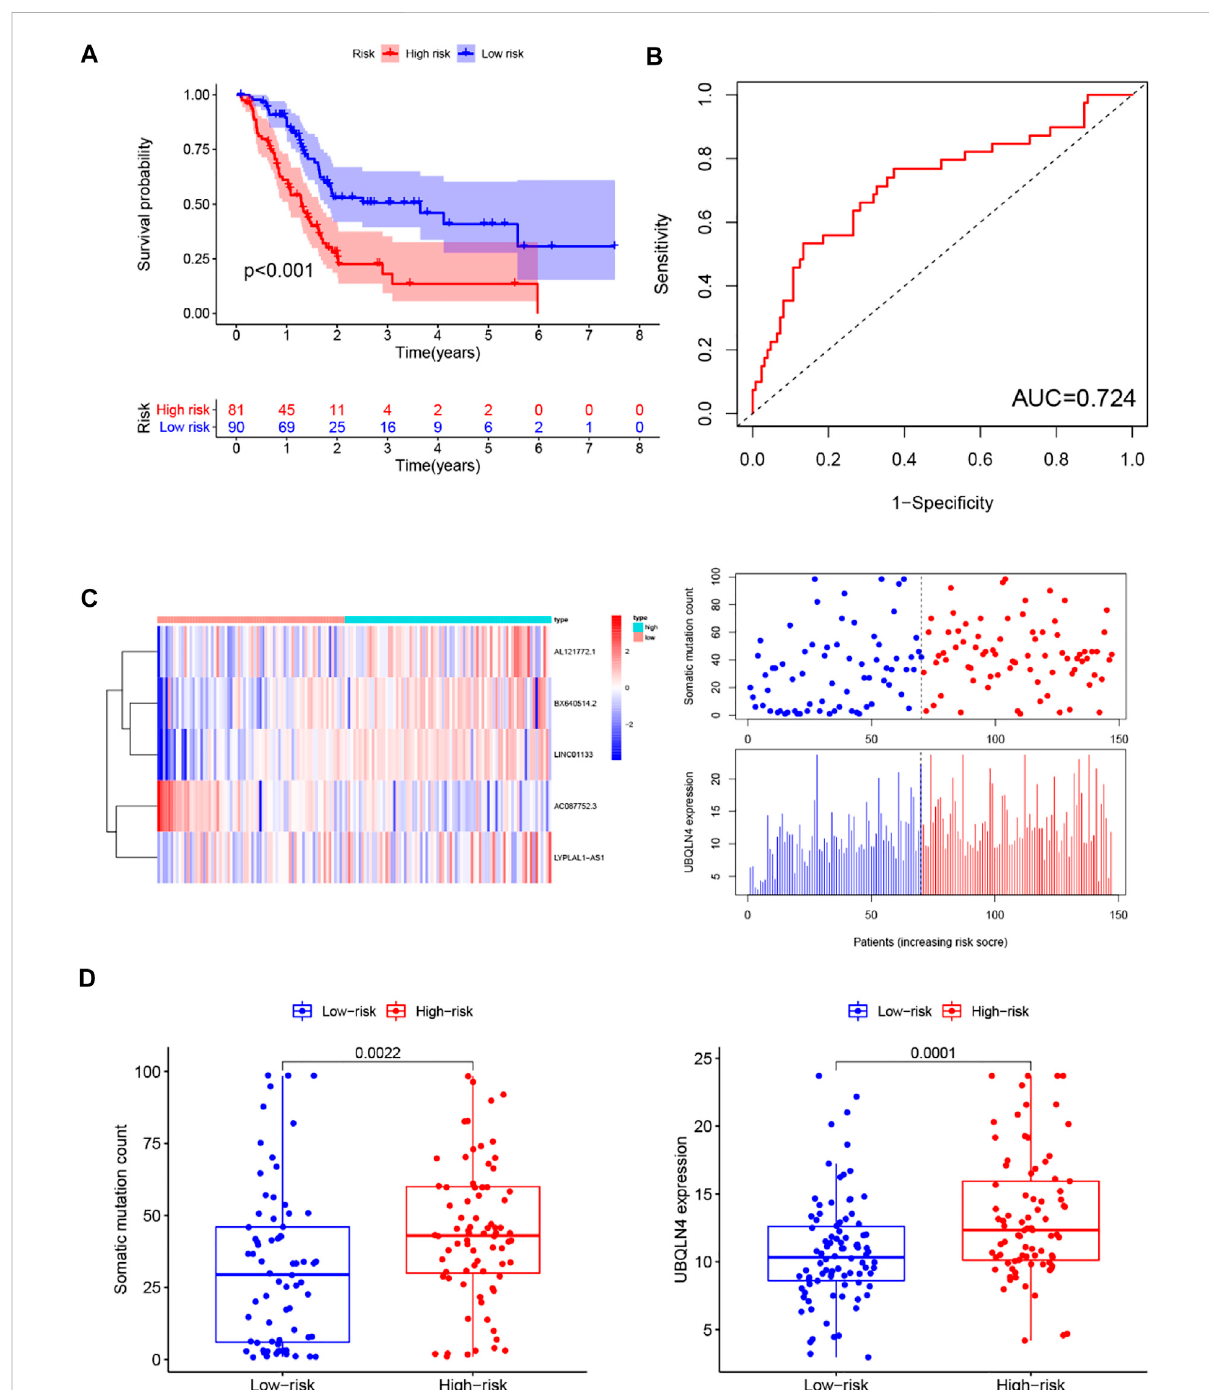
FIGURE 6 Predictive performance evaluation of the GILncSig in patients with pancreatic cancer in the TCGA set. (A) Kaplan – Meier survival curves of patients in the high- and low-risk groups separated by the median GILncSig score in the TCGA set. (B) LncRNA expression patterns and the distribution of somatic mutation and UBQLN4 expression with increasing GILncSig score in the TCGA set. (C) Time-dependent ROC curves for 1- year survival prediction of the GILncSig in the TCGA set. (D) Boxplots of comparison of the somatic mutation counts and the UBQLN4 expression between the high- and low-risk groups in the TCGA